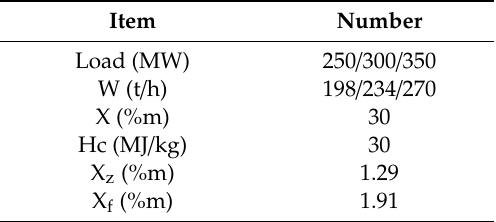
Table 8. Relevant parameters of the residual char dynamic model.